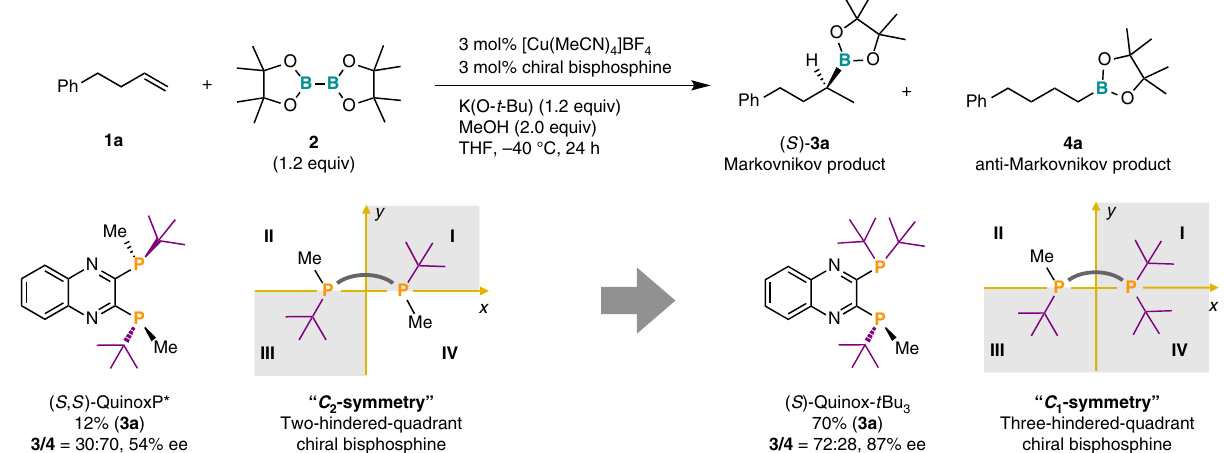
Fig. 2 The fi rst ligand evaluation step. Yields (%) of 3a and regioselectivities ( 3 / 4 ) were determined by the gas chromatography (GC) analysis using the crude material. Enantioselectivities (% ee) were determined by the high-pressure liquid chromatography (HPLC) analysis with a